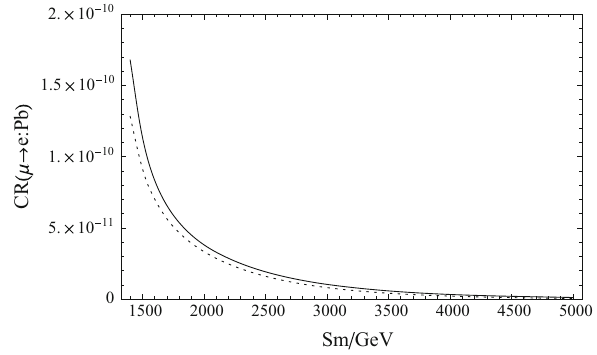
Fig. 9 With m 1 = 1000GeV, m 2 = 1000GeV, M Lf = 10 4 GeV 2 , and V Lt = 3000GeV, the contribution to μ → e tan β L = 2 . 0, g L = 1 6 conversion rate in nuclei Pb versus S m with tan β = 2 (solid line) and 3 (dotted